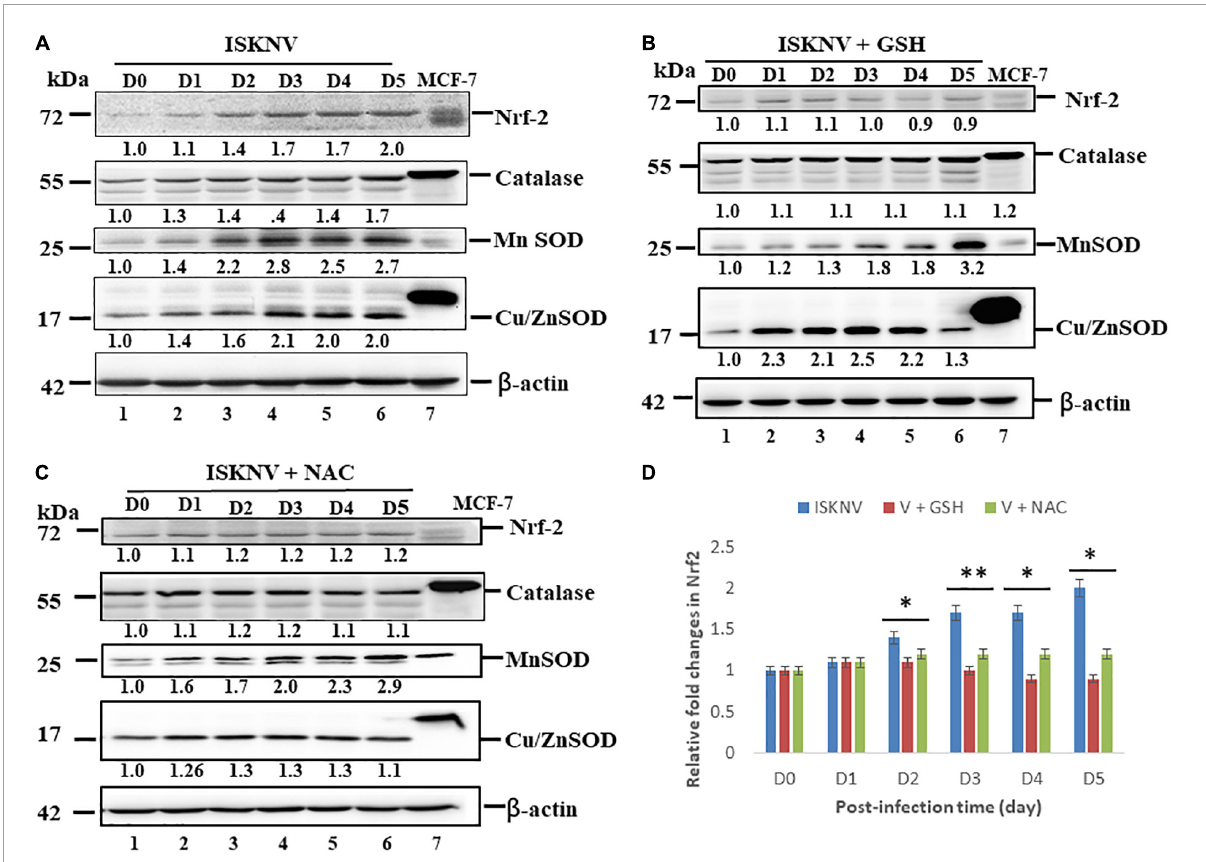
FIGURE3 Infectious spleen and kidney necrosis virus (ISKNV) infection can induce Nrf2 and antioxidant enzyme expression in GF-1 cells. (A–C) Infection of fish cells with ISKNV from day 0 to day 5, showing ISKNV-infected cells (A) , GSH-treated and virus-infected cells (B) , and NAC-treated and virus-infected cells (C) , with the stress transcriptional factor Nrf2 and the antioxidant enzyme catalases Cu/MnSOD and ZnSOD, as determined by western blot analyses. Lanes 1–6 correspond to ISKNV-infected fish cells from day 0 to day 5, while lane 7 shows the MCF7 cell lysate. Membranes were probed with anti-mouse Nrf2, catalase, Cu/MnSOD, and ZnSOD monoclonal antibodies (1:7,500) and an anti-mouse β -actin monoclonal antibody (1:12,500). (D) Quantification of protein and Nrf2 expression levels ( N = 3) using the Image J software, from panels (A–C) . All data were analyzed using either paired or unpaired Student’s t -tests, as appropriate. ∗ P < 0.01 and ** P <